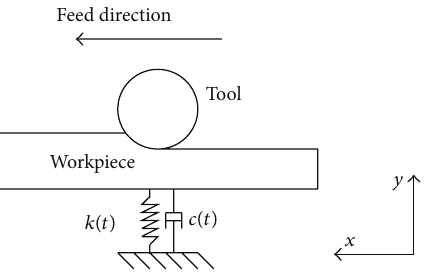
Figure 6: Dynamic milling model of